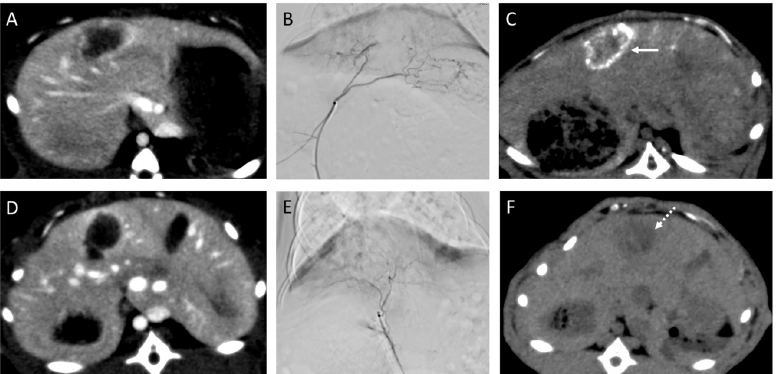
Fig 6. Representative images showing Lipiodol deposition. (A–C) Images for a rabbit in the experimental group. The s/o/w miriplatin emulsion was injected via the left hepatic artery. (C) Dense Lipiodol accumulation observed two days after TACE (white arrow). (D–F) Images for a rabbit in the control group. Miriplatin suspension was injected via the left hepatic artery. (F) Slight accumulation of Lipiodol observed two days after TACE (white dashed